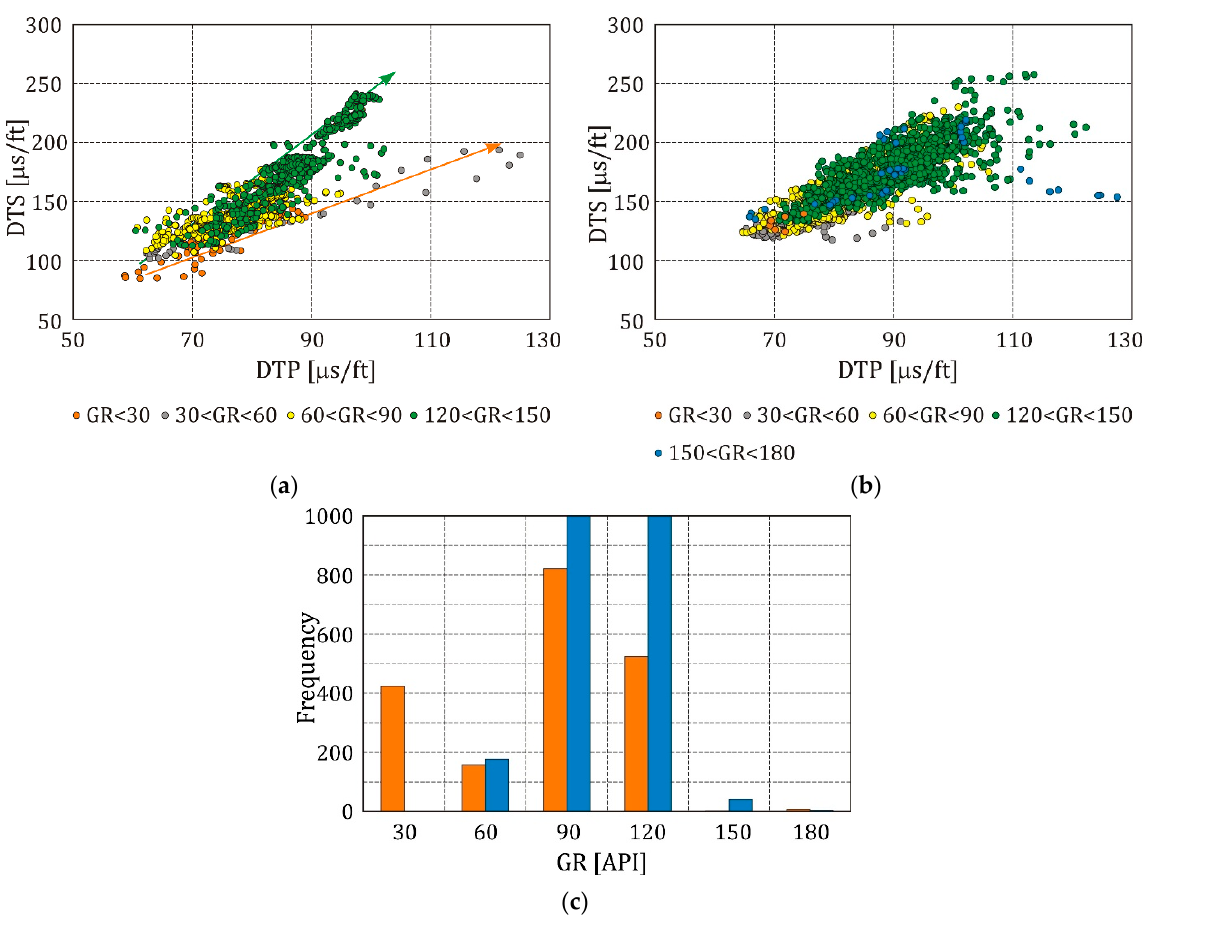
Figure 8. ( a ) Lithology differentiation on the basis of cross ‐ plot S ‐ waves (DTS) vs. P ‐ waves (DTP), GT ‐ 1 borehole, TRe, Rhaetian (2335–2528 m); sandstones intercalated by mudstones and claystones; coloured scale related to gamma ‐ ray (GR), orange line indicates sandstone, green—shales. ( b ) Lithology differentiation on the basis of cross ‐ plot DTs vs. DTP, GT ‐ 1 borehole, TK, Keuper (2528–2752 m); clayey and muddy formations with calcareous and dolomitic substance; coloured scale related to GR. ( c ) GR data histogram; GT ‐ 1 borehole, TRe, Rhaetian (red), TK, Keuper (blue).